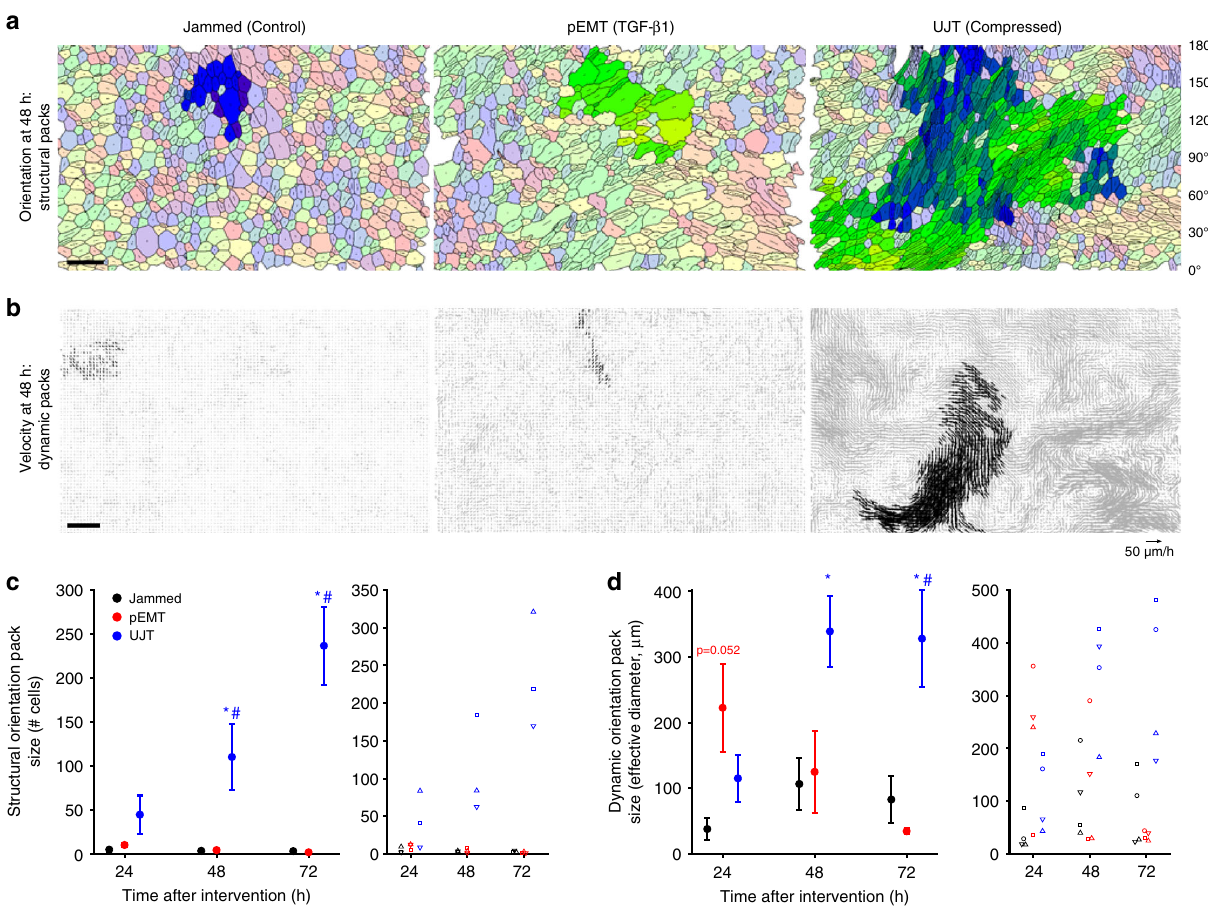
Fig. 3 During UJT but not pEMT, cellular alignment and cellular migration organize into cooperative packs. a Using a community- fi nding algorithm (see “ Methods ” section), cellular orientations were seen to align into orientational packs. Each cell is shown with an orientation director whose length is proportional to AR. Largest orientational packs highlighted in bold colors. Scale bar is 50 µ m. c Cells did not exhibit large structural packs when jammed or during pEMT at any time point. ( n = 3 donors from independent experiments). During UJT, by contrast, cells aligned into packs whose median size progressively grew in cell number from 24 to 72 h. Left panel: mean ± SEM for n = 3 donors; right panel: measurements for each donor, delineated by symbol shape. b Using velocity fi elds obtained by optical fl ow and the same community- fi nding algorithm, cellular motions were seen to organize into oriented migratory packs. Velocity vectors are shown for a 2-h period, with members of the largest dynamic pack highlighted in black. Scale bar is 100 µ m. d In jammed layers dynamic packs remained relatively small at all time points ( n = 4 donors from independent experiments). During pEMT dynamic packs were substantially larger at 24 h but returned to baseline by 48 h. During UJT, by contrast, dynamic packs grew dramatically in size and remained elevated out to 72 h. Left panel: mean ± SEM for n = 4 donors; right panel: measurements for each donor, delineated by symbol shape. See also Supplementary Table 1 and online Source Data fi le. * p < 0.05, vs. control; # p < 0.05, UJT vs. pEMT, color-coded according to which sample is referenced; one-way ANOVA followed by post-hoc multiple comparisons with Bonferroni